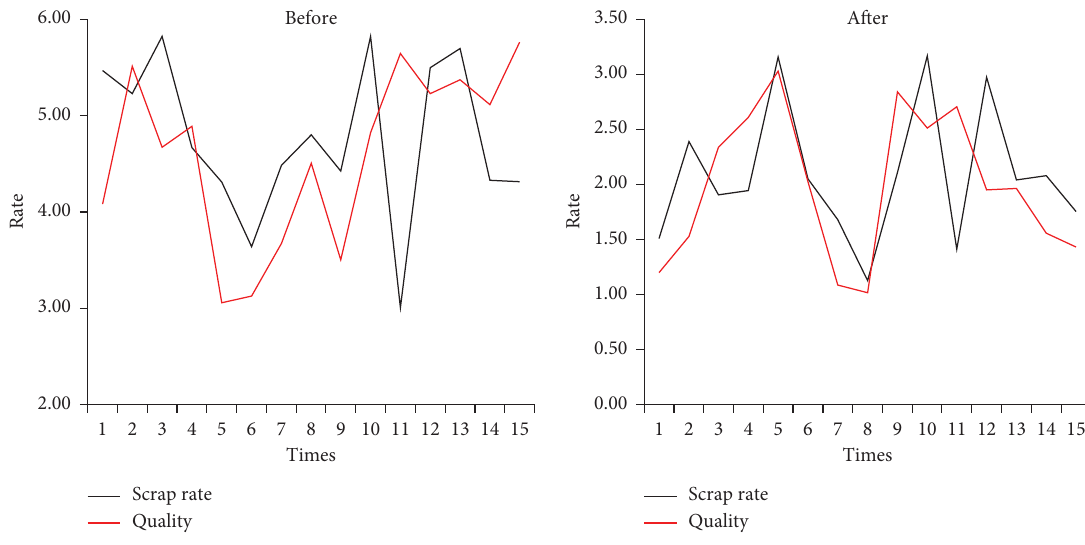
Figure 10: The quality of alumina ceramic